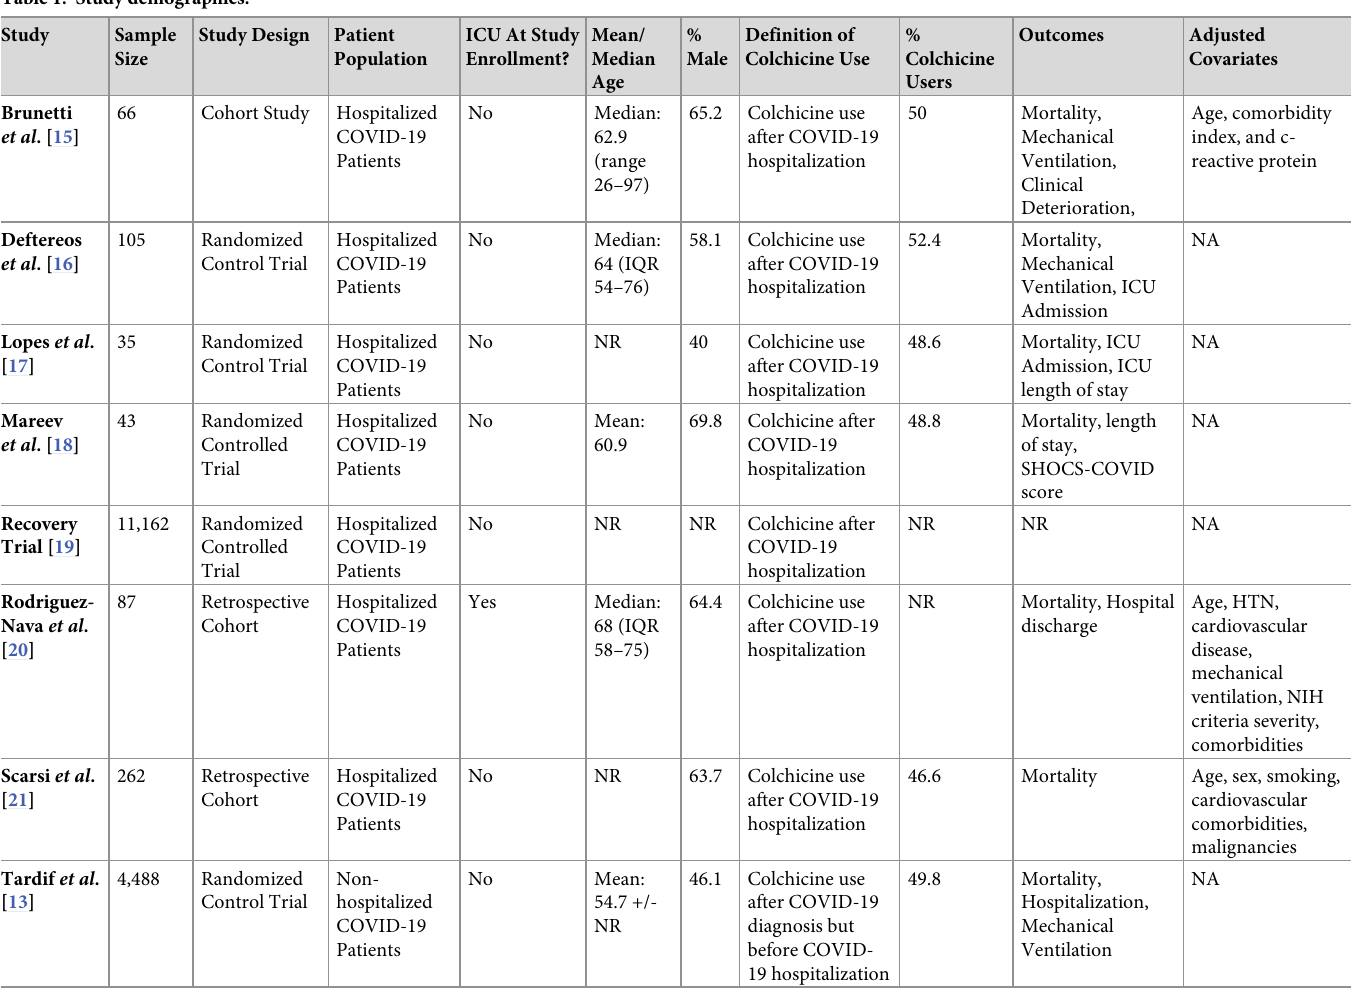
Table 1. Study demographics.